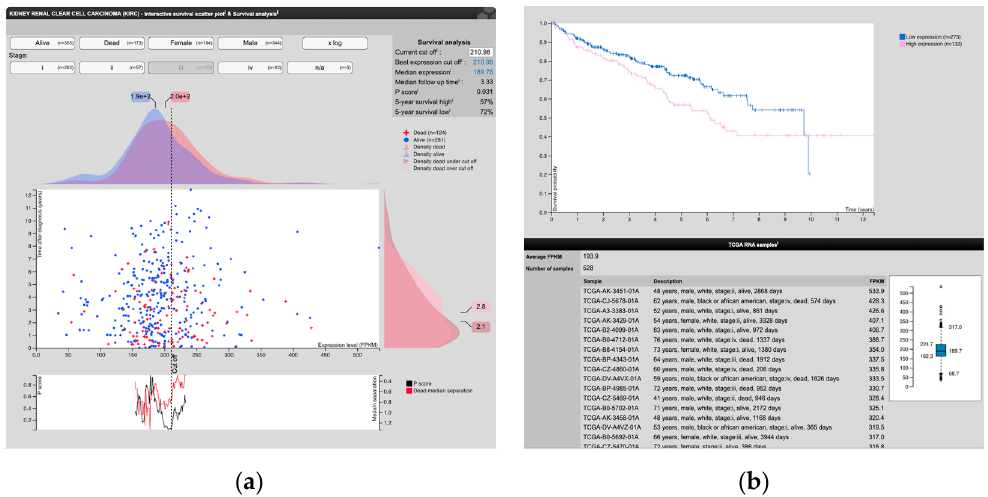
Figure 7. Comparative assessment of 5-year survival rate between ccRCC from TCGA database patients with high and low CLIC1 expression. The survival scatter plot ( a ) and the Kaplan–Meier survival curve ( b ) for stage III ccRCC showed significant survival differences related to CLIC1 expression levels. Note that high CLIC1 expression significantly reduces the 5-year survival rate ( b ) according to the Kaplan–Meier curve.